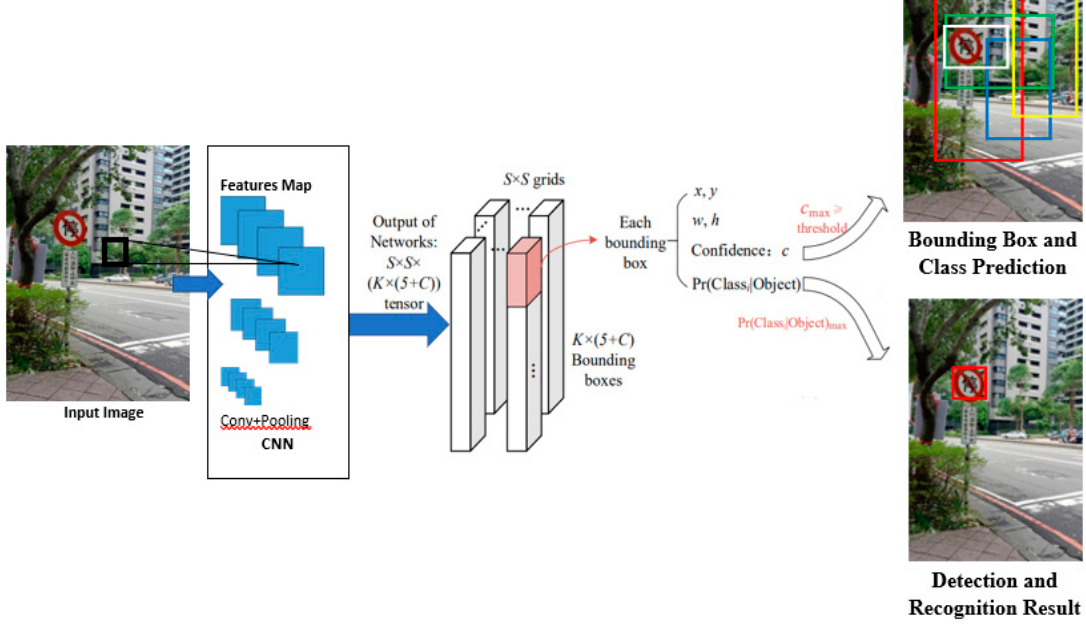
Figure 3. Yolo V3 SPP architecture.